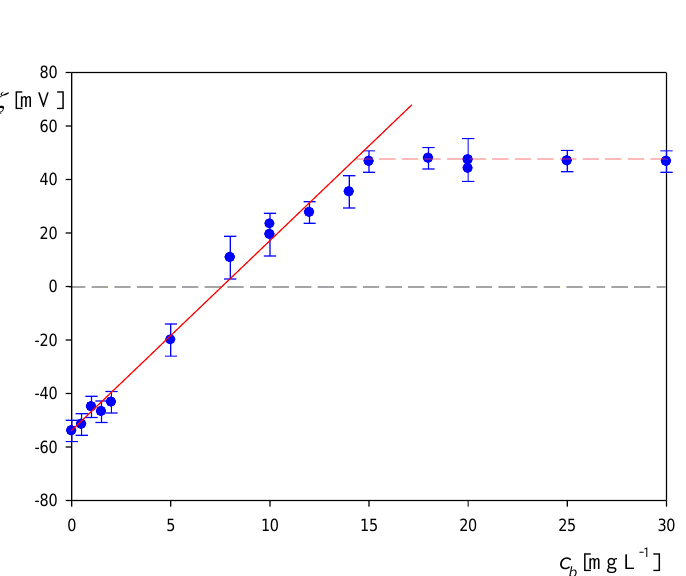
Figure 5. Dependence of the zeta potential of the polystyrene particles on the HSA concentration in the suspension before mixing: pH 3.5, 10 mM NaCl, particle concentration 500 mgL − 1 , ( ● ) experimental results derived from the LDV measurements. The solid red line shows the linear fit of experimental data, and the dashed horizontal line shows the zeta potential of the protein in the bulk.